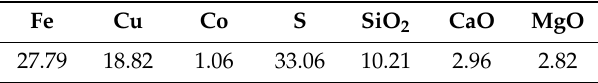
Table 1. Chemical composition of cobalt ore (mass,